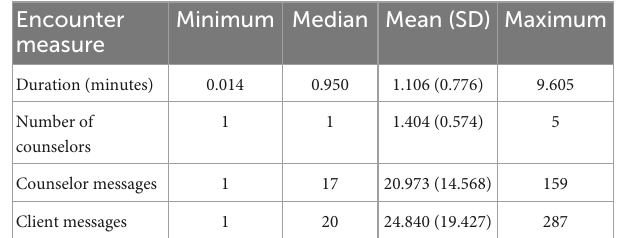
TABLE 1 Data summary of crisis counseling